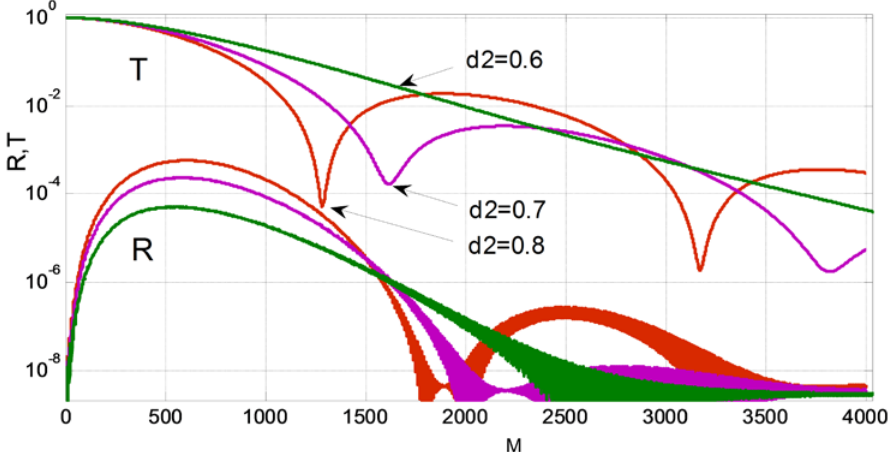
Figure 16. The effect of abnormal blocking for the forward diffraction. The dependence of the transmitting and reflection power of the fundamental mode of silicon wire on the number of segments (periods). The optimal number of grating periods M = 1280 and 3170 at d 1 = d 2 = 0.8 µm, ( Dd = 0.0 µm, vertical boundaries) and M = 1615 and 3820 at d 2 = 0.7 µm ( Dd = 0.1 µm, weak boundary slope) and at d 2 = 0.6 µm ( Dd = 0.2 µm, strong boundary slope). The optimal wavelength at the barrier: λ 0 = 1.55345 µm, 1.55580 µm, 1.55810 µm, respectively. Silicon oxide thickness d = 0.3 µm, refractive index of polymer segments n p = 1.521, height H = 1.0 µm, grating period d 1 + d 0 = 1.6 µm. Analysis made using 2D MoL plus EIM.